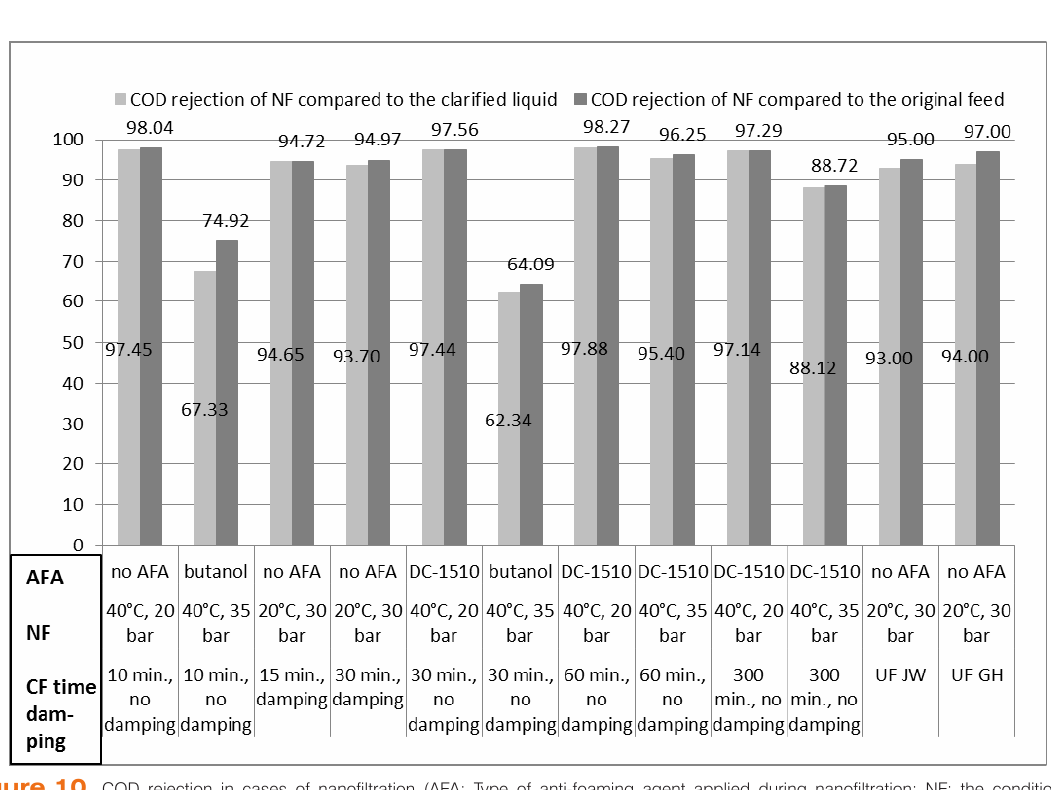
Figure 10. COD rejection in cases of nanofiltration (AFA: Type of anti-foaming agent applied during nanofiltration; NF: the conditions of nanofiltration temperature and trans-membrane pressure respectively; CF-time: the duration of centrifugal separation; damping: forced damping of no damping is indicated; UF JW: pre-treatment by ultrafiltration investigated by JW type membrane; UF GH: pre- treatment by ultrafiltration investigated by GH type